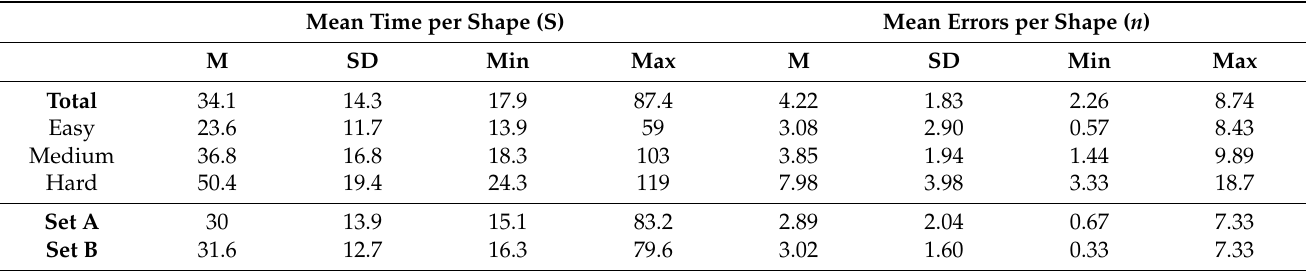
Table 3. Detailed SLURP descriptive data (for n = 22 participants) for mean time taken to complete shape in seconds and mean number of errors made per shape for the total ( n = 20), the easy ( n = 7), medium ( n = 9) and hard ( n = 3) sets, in addition to the shortened Set A ( n = 6) and Set B ( n = 6), which both included 2 shapes from each difficulty